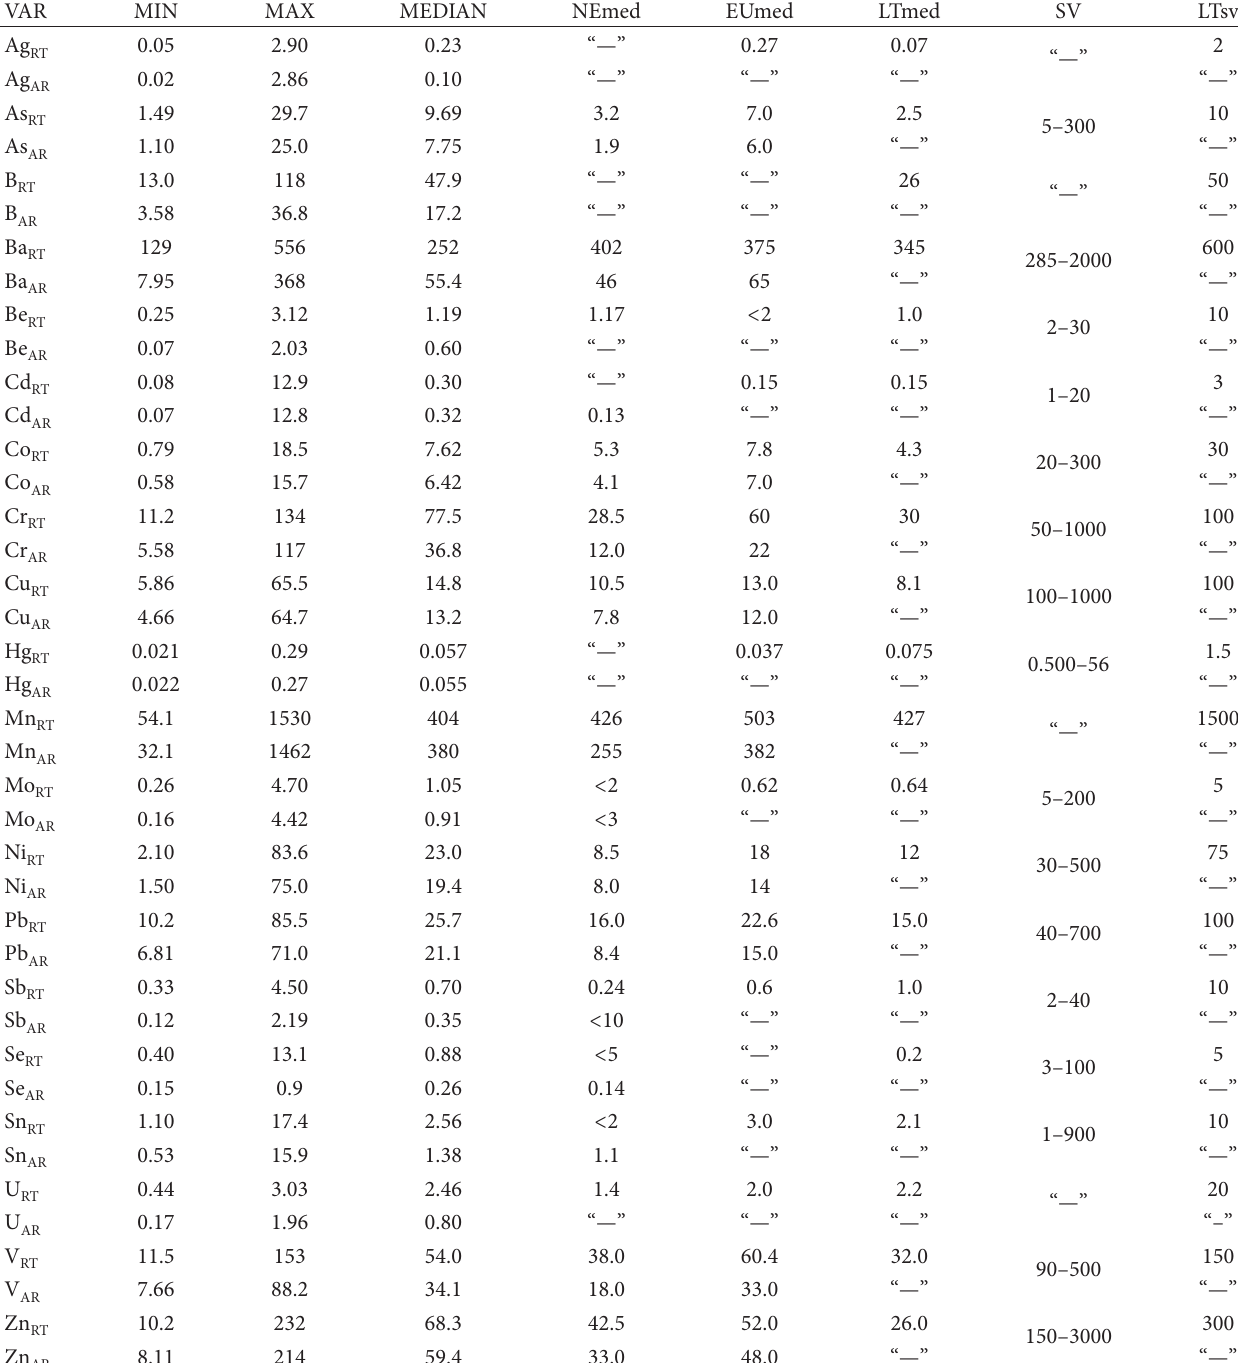
T 2: Statistical characteristics of WEPAL ISE European soil samples compared to other